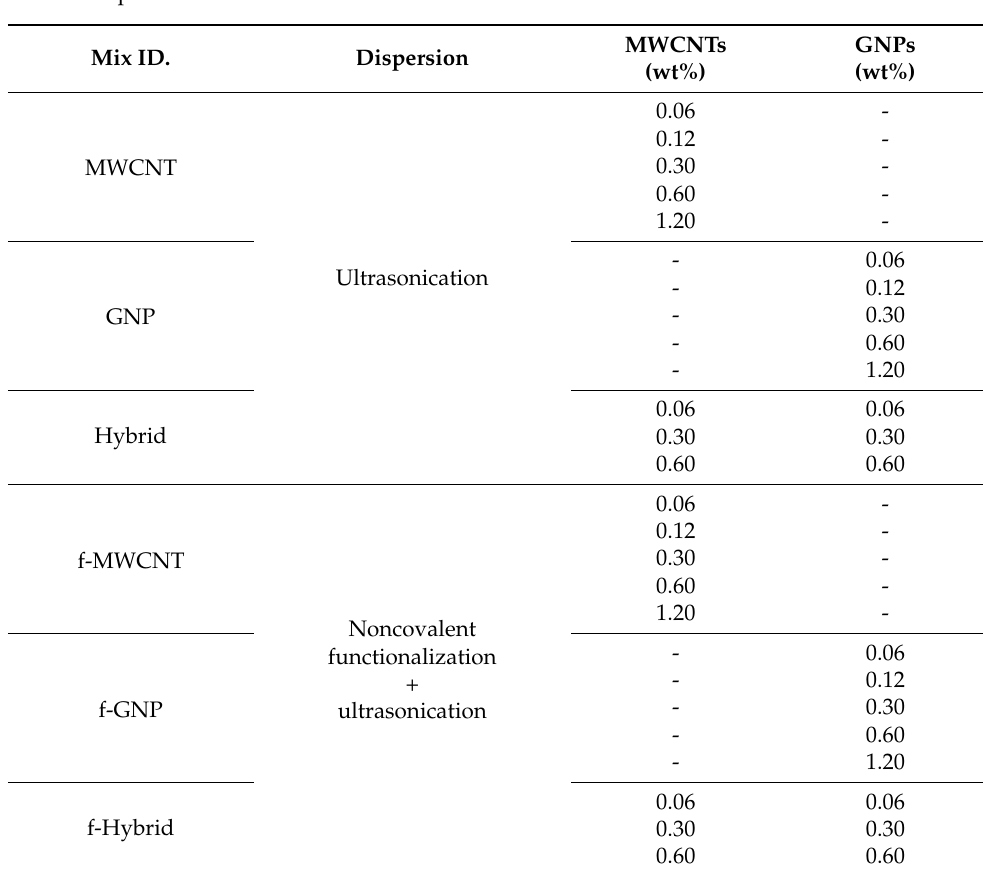
Table 3. Experimental